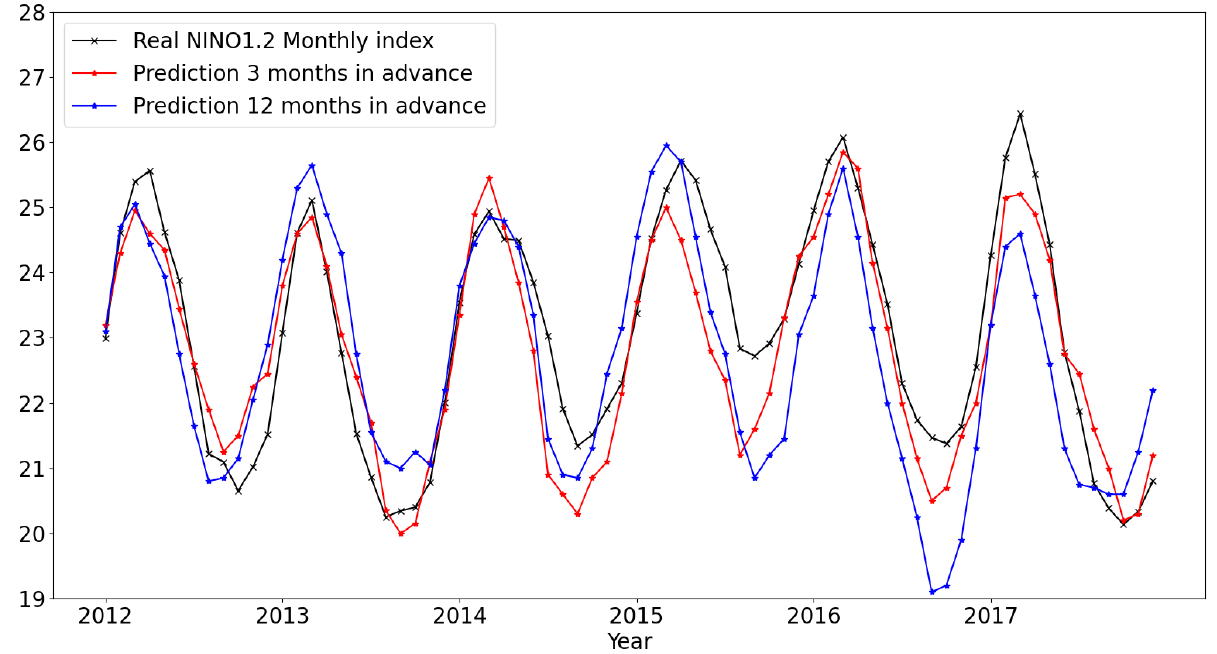
Figure 5. Monthly NINO1.2 predictions (January 2012 to December 2017) using SVD based dimensionality reduction compared with the original NINO1.2 index (black curve). x-axis is months starting from January,